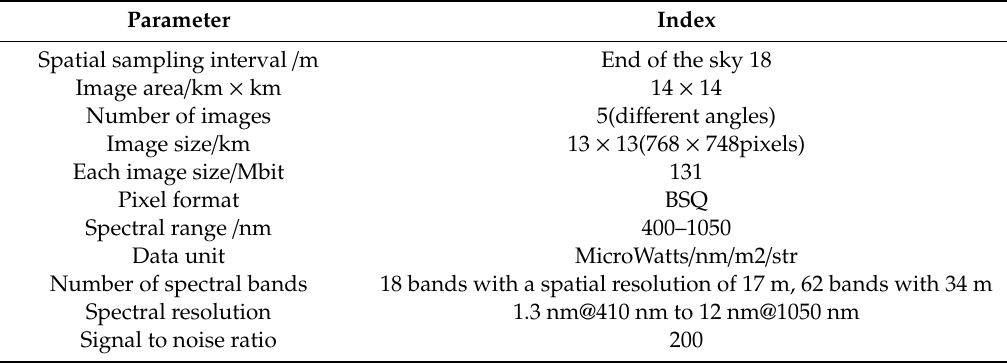
Table 1. Compact high resolution imaging spectrometer (CHRIS) product